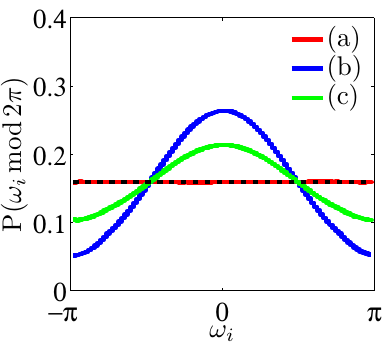
Figure 2: Probability distribution of the turn rate noise ω ( k ) modulus 2 π obtained from 1,000,000 time increments and by varying the noise parameters in Eq. (5): (a) α = 0 . 01 , λ = 0 . 1 , and γ = 5 ; (b) α = 1 . 71 , λ = 0 . 1 , and γ = 5 ; (c) α = 1 . 71 , λ = 0 . 5 , and γ = 5 ; η = 1 . The black dashed line represents uniform